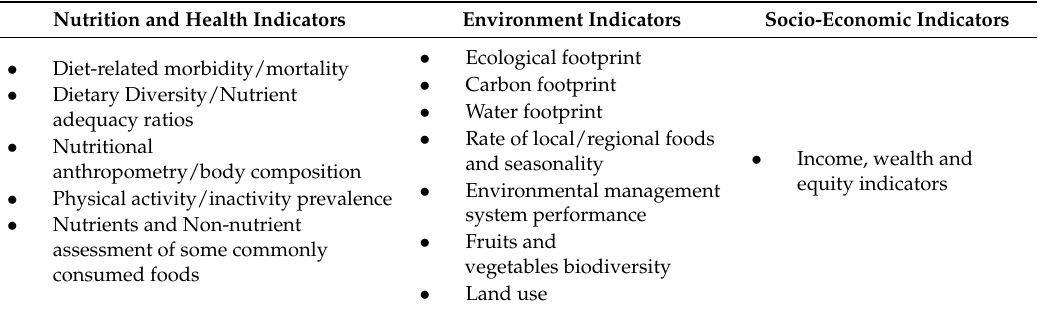
Table 4. The harmonized indicators for assessing sustainable food